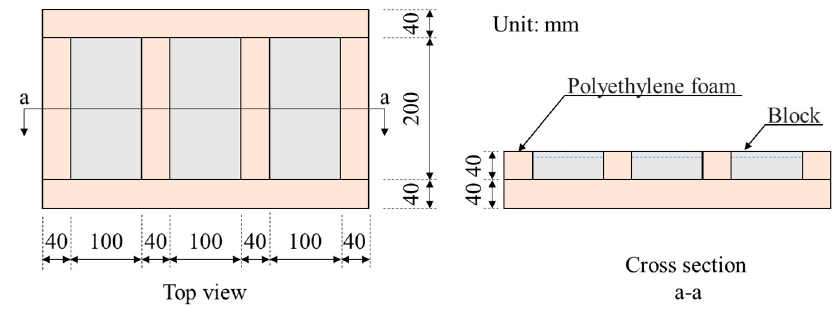
Figure 4. Polyethylene foam form.